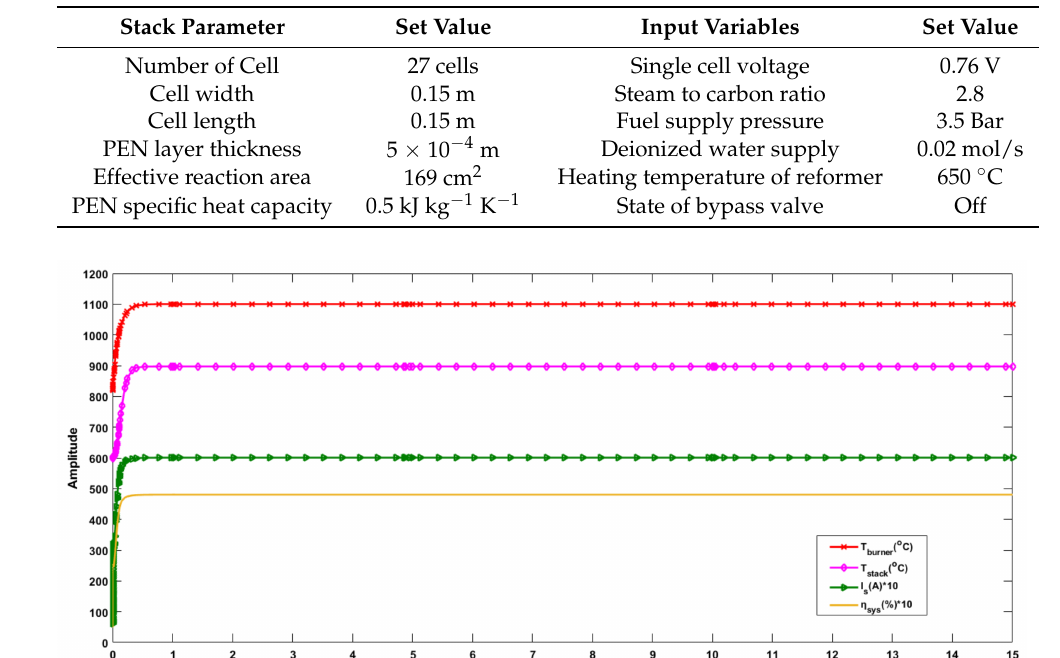
Figure 7. SOFC system model structure. Table 5. SOFC system main parameters.